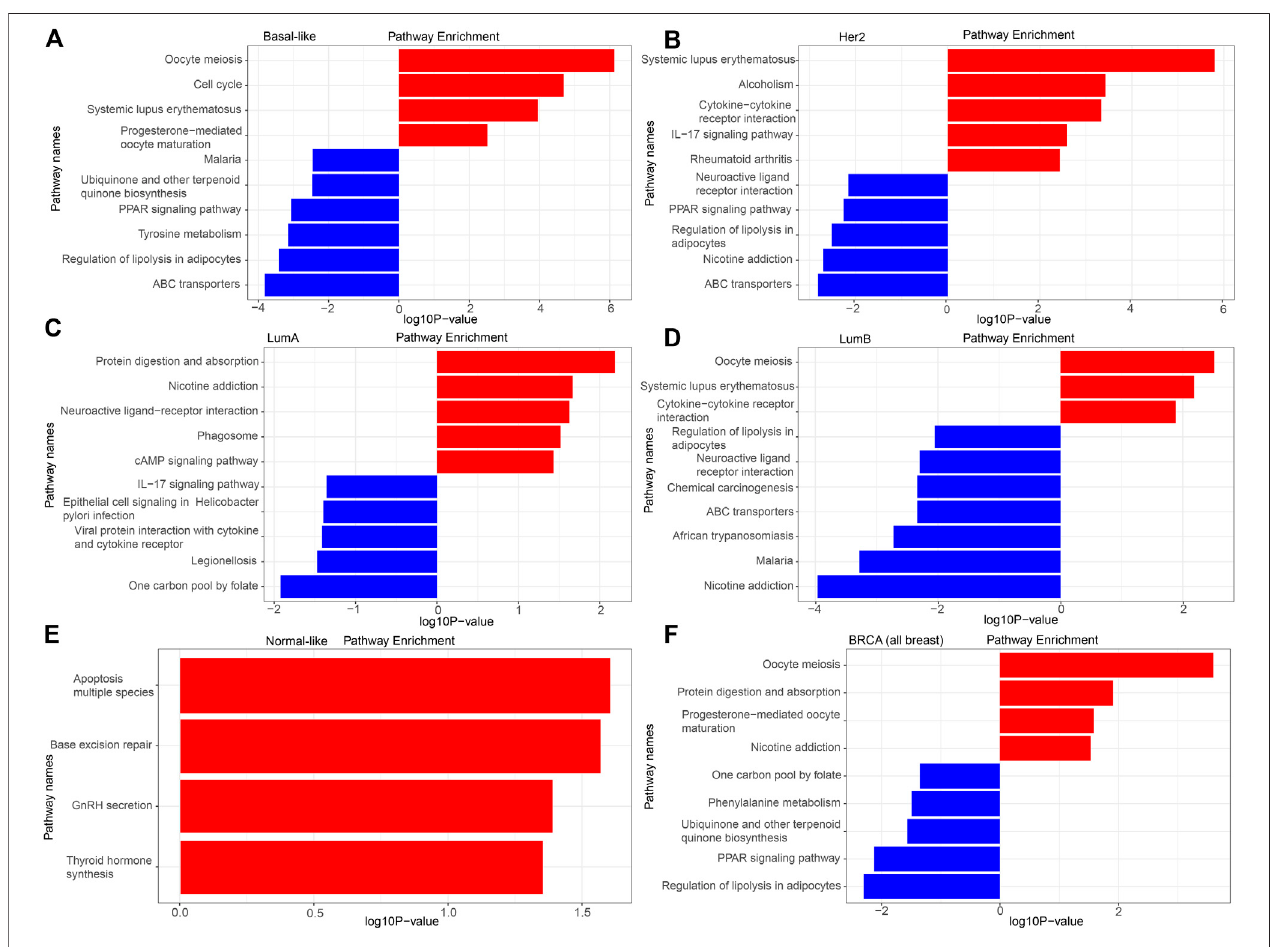
FIGURE 4 | KEGG analysis of the DEGs. (A) Basal-like; (B) Her2; (C) LumA; (D) LumB; (E) Normal-like; (F) BRCA (all breast